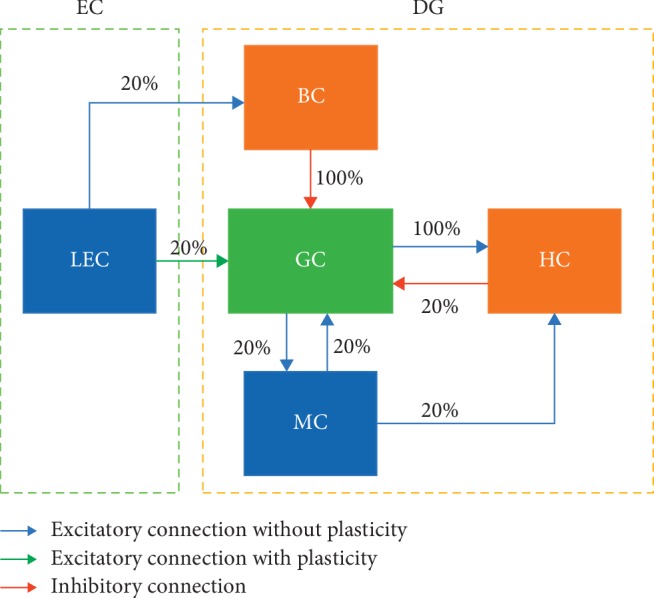
The structure of our simulated SNN. The LEC and DG are shown in hollow green and orange dotted boxes, respectively, the filled blue area represents excitatory neurons (LEC and MCs), the filled green area represents excitatory neurons with neurogenesis (GCs), and the filled orange area represents inhibitory neurons (BCs and HCs). The blue arrow represents excitatory connections without plasticity, the green arrow indicates excitatory connections with plasticity, and the red arrow represents inhibitory connections; the numbers near the arrows indicate the projection ratio.